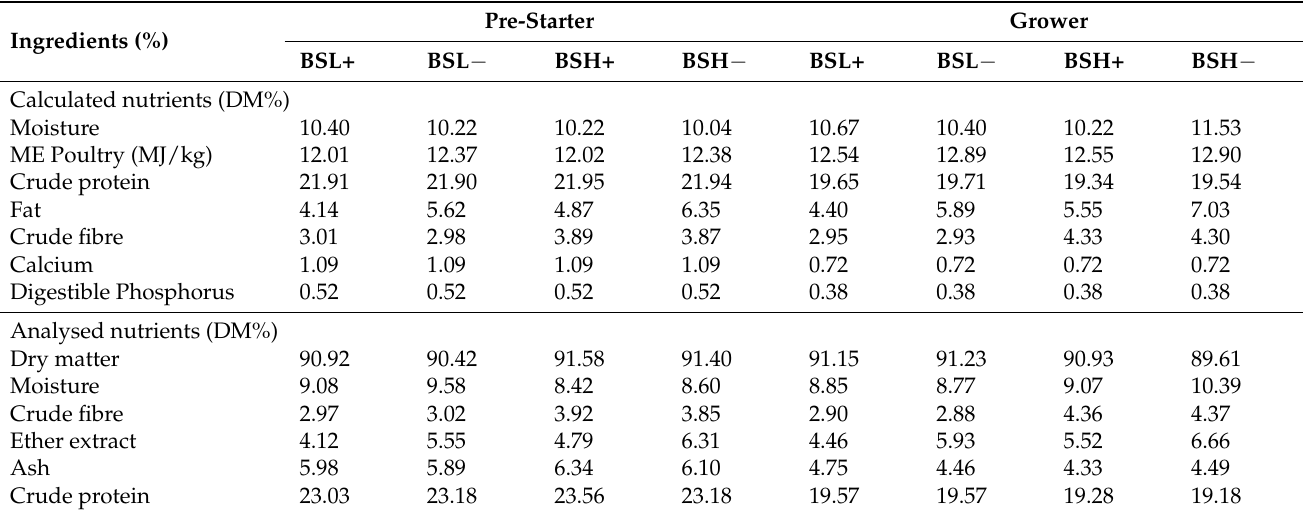
Table 3. Calculated and analysed basal dietary treatments formulations used in the experiment (pre-starter and grower).